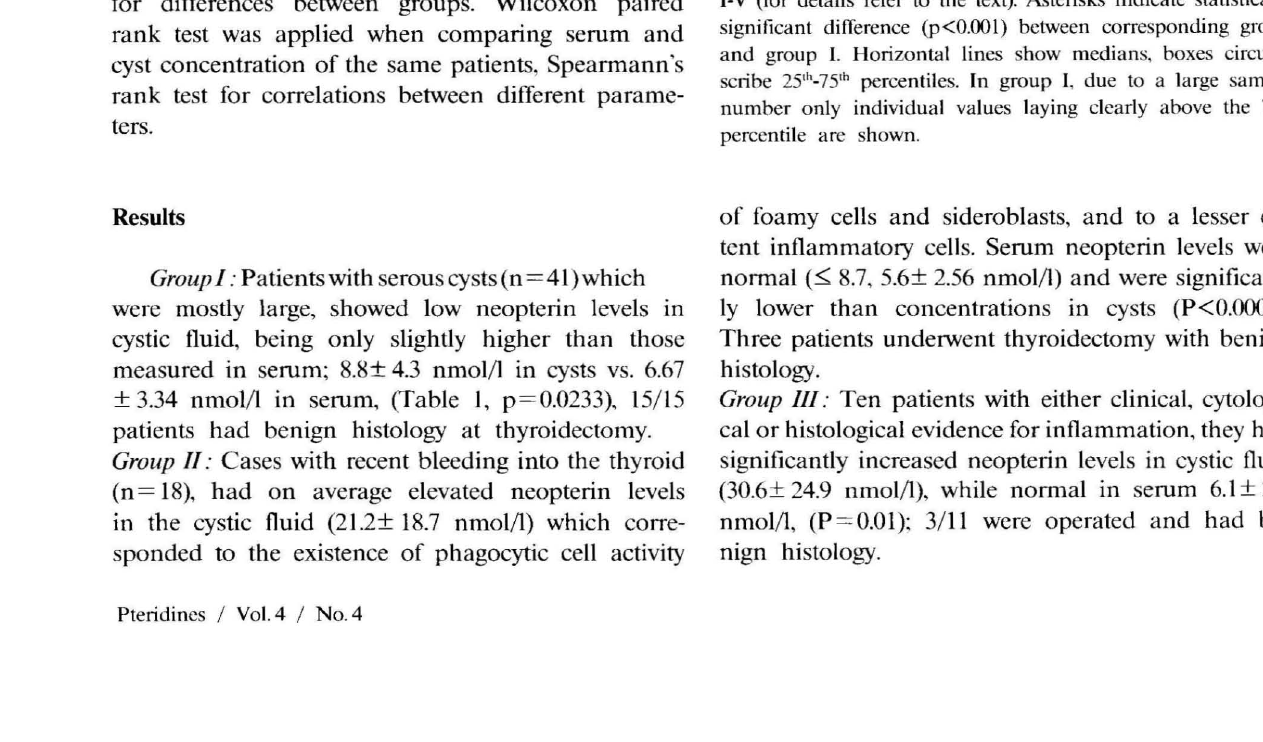
Figure I. Neopterin levels (nmol/l) in cyst Iluid in groups I-V (for details refer to the text). Asterisks indicate statistically significant difference (p<O.OOI) between corresponding group and group I. Horizontal lines show medians, boxes circum scribe 25'h-75'h percentiles. In group I, due to a large sample number only individual values laying clearly above the 75'h percentile are